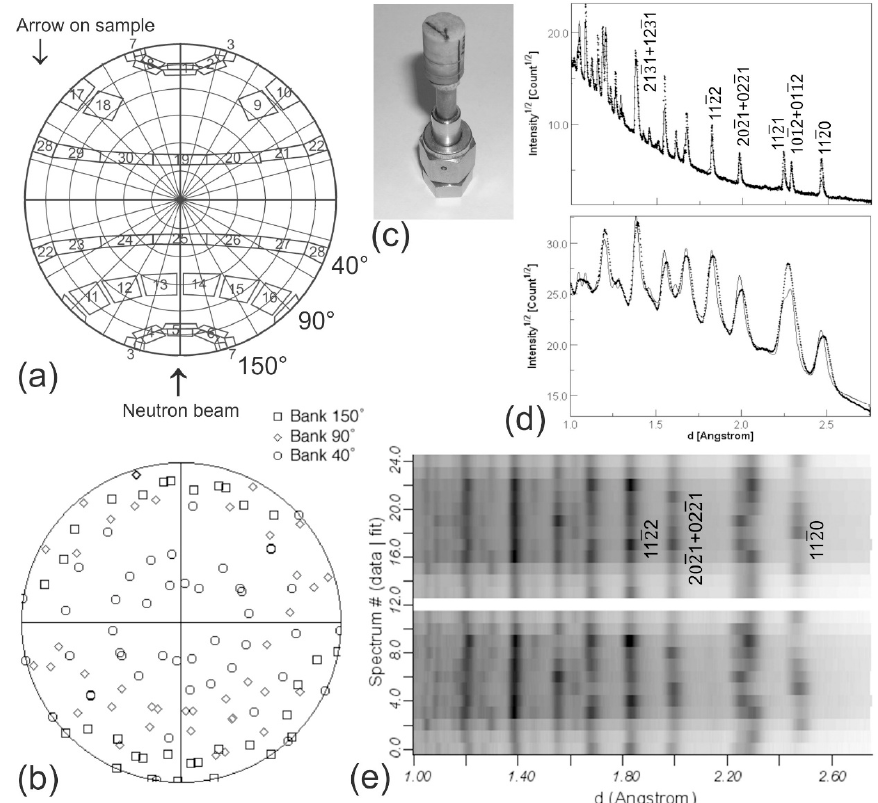
Figure 6. Neutron diffraction texture measurements with HIPPO. ( a ) shows the pole figure coverage using 3 detector banks (40°, 90°, and 150°). The approximate area covered by a single detector is shown on the pole figure in equal area projection. ( b ) Coverage with 4 sample rotations around the vertical axis (0°, 45°, 67.5°, and 90°). ( c ) View of a cylindrical quartzite sample. The diameter of the cylinder is 1 cm. ( d ) Diffraction spectrum for the 40° and 90° detector banks (dots) and the corresponding Rietveld fit (line). Some diffraction peaks of quartz are indexed. ( e ) Stack of diffraction spectra for one rotation for the 40° detector. Bottom are the experimental data and top is the Rietveld fit. Intensity variations correspond to crystal preferred orientation.